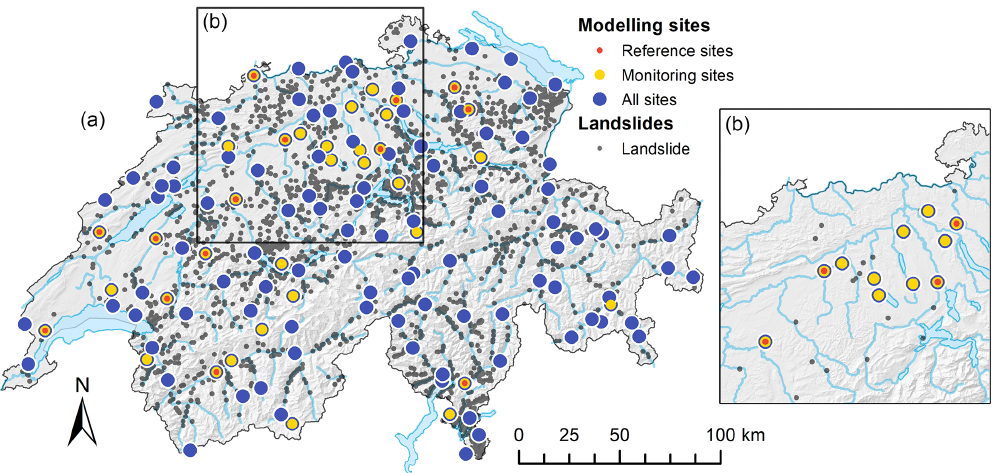
Figure 1. Map of Switzerland showing the locations of the soil moisture modelling sites (coloured points) and the landslide locations (black points), including (a) all sites and all landslides of the entire study period from 1981 to 2019 and (b) a subset of sites and landslides that were triggered during a series of rainfall events between 30 April and 3 May